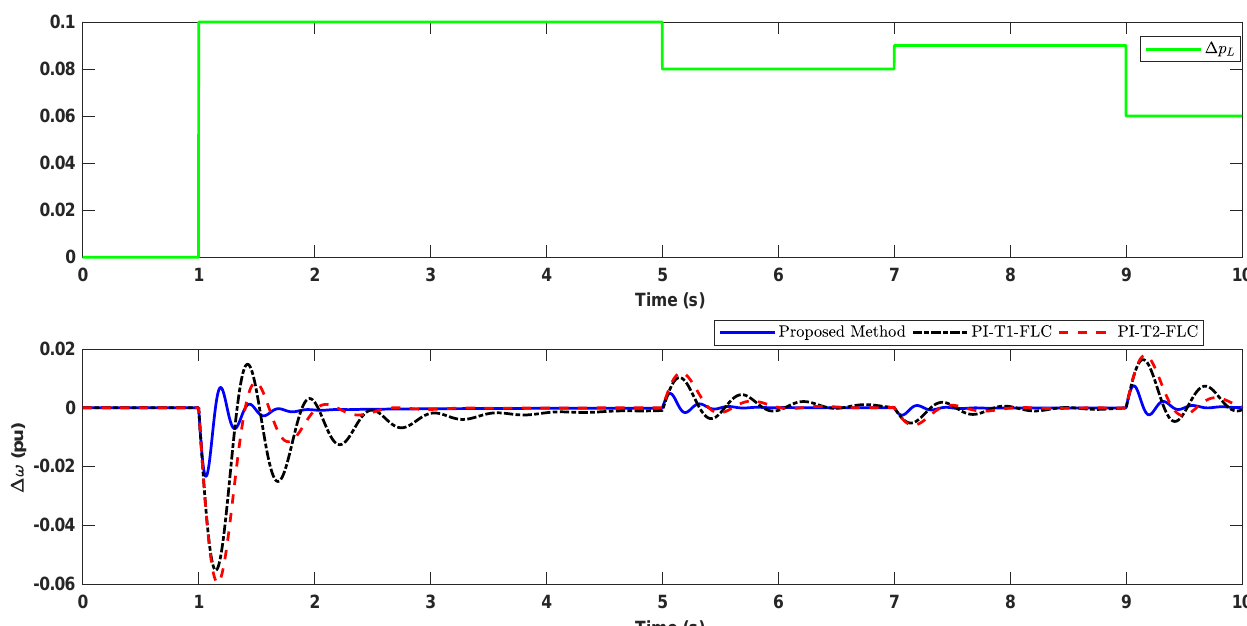
Figure 9. Example 1: Scenario 3: Frequency regulation in the presence of multiple load changes ( ∆ p L ), and all parameters are changed.